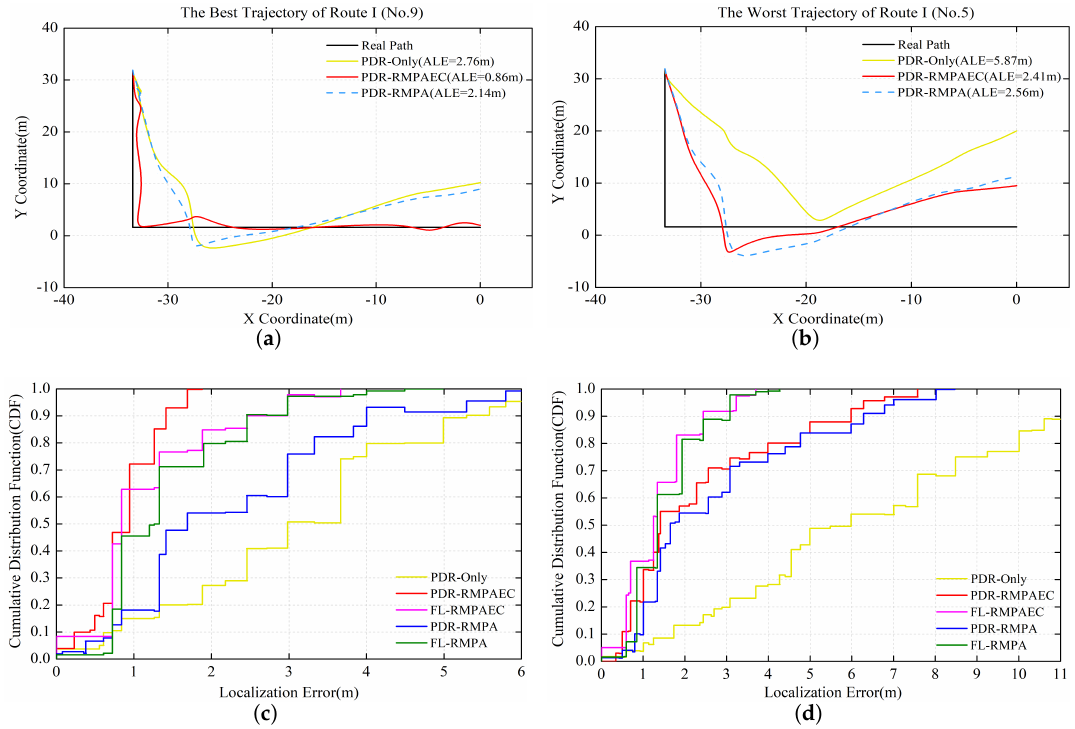
Figure 6. Localization results in Route I: ( a ) the best No. 9 PDR-RMPAEC trajectory with ALE = 0.86 m; ( b ) the worst No. 5 PDR-RMPAEC trajectory with ALE = 2.41 m; ( c ) CDF of localization error of the No. 9 trajectory; and ( d ) CDF of localization error of the No. 5